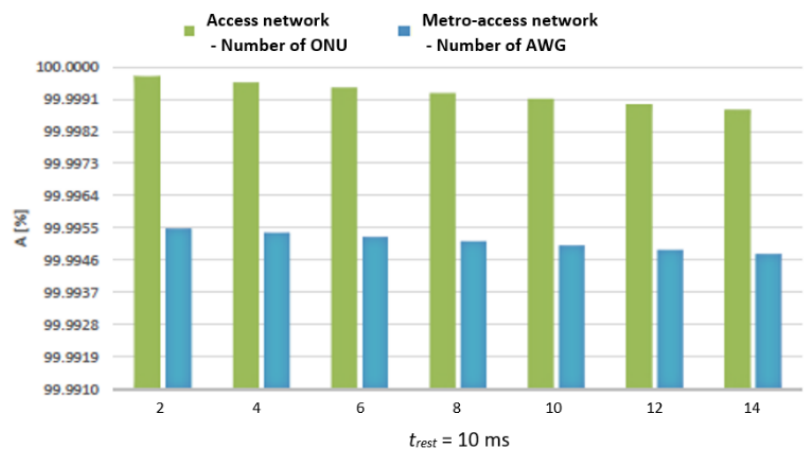
Figure 10. The network availability of RING WDM-PON protection scenarios for different numbers of elements.